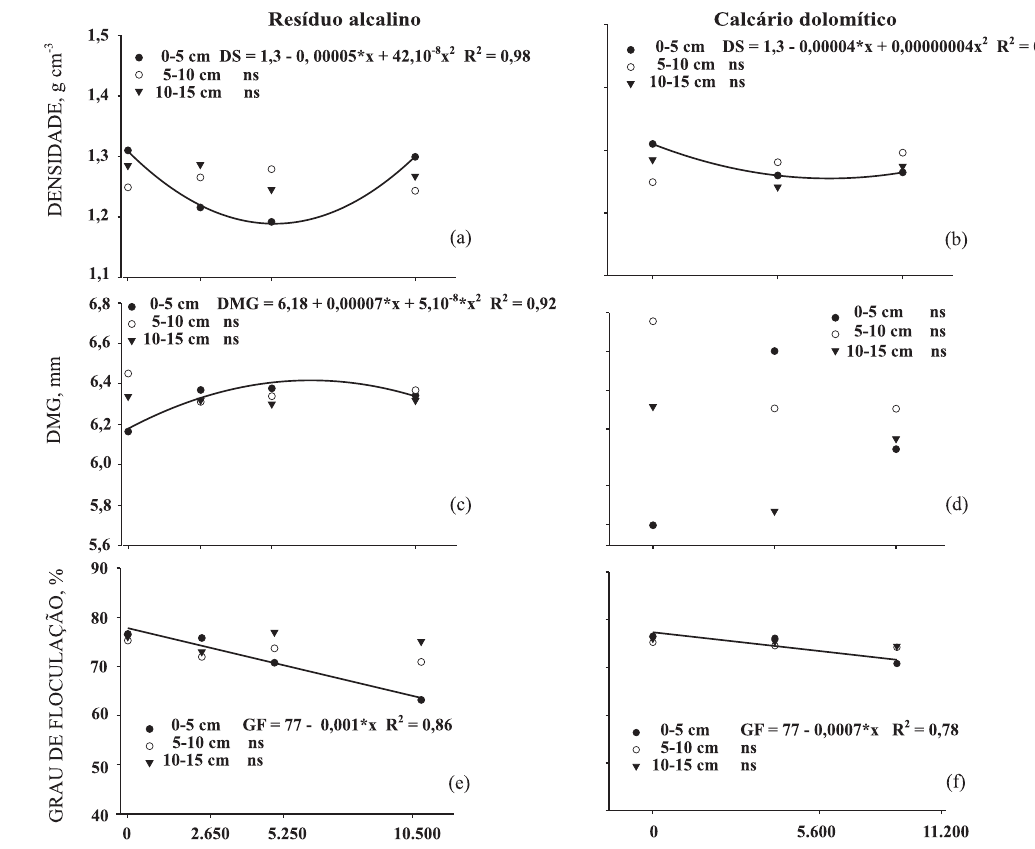
Figura 3. Densidade do solo (a) e (b), DMG: diâmetro médio geométrico (c) e (d) e grau de floculação da argila (e) e (f) de um Cambissolo Húmico alumínico submetido a doses de resíduo alcalino (esquerda) e calcário (direita), aplicadas em superfície, calculadas com base no método SMP (*, ** e ns: significativo a 5 e 1 % e não significativo).